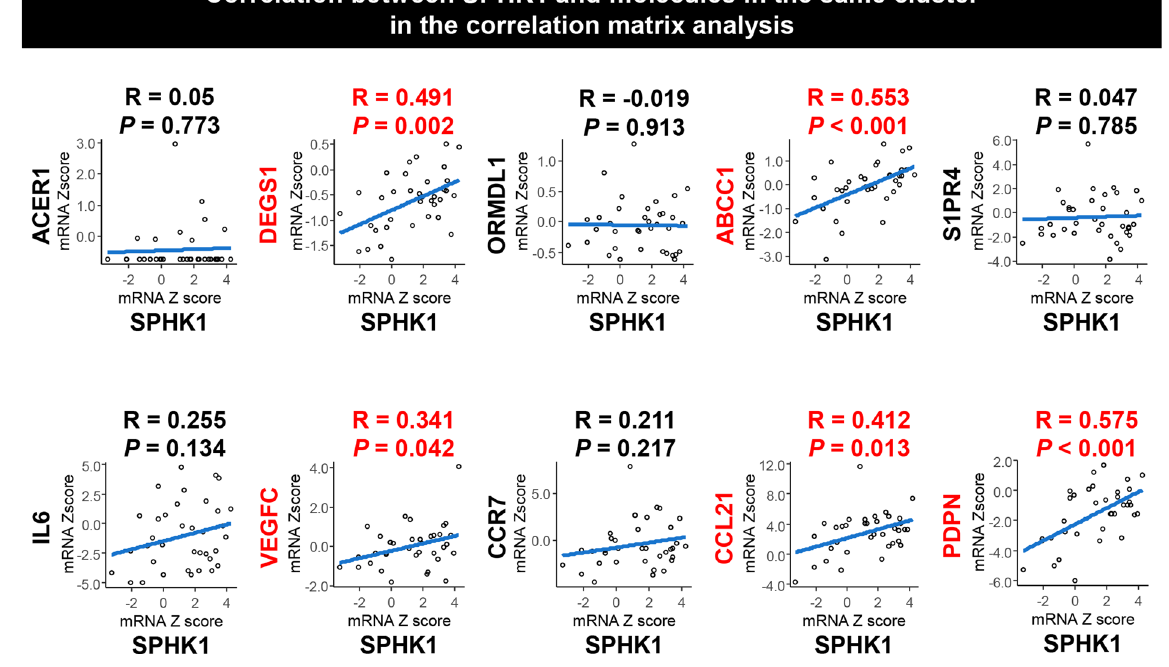
Figure 5. The gene expression level of SPHK1 positively correlated with those of lymphangiogenesis-related or lymphatic metastasis-related substrates in biliary tract cancer. Pearson correlations were calculated between gene expression level of SPHK1 and those of ACER1, DEGS1, ORMDL1, ABCC1, S1PR4, IL6, VEGFC, CCR7, CCL21 and PDPN in biliary tract cancer in TCGA cohort (36 samples of cancer tissue in cholangiocarcinoma cohort). All tests were two-sided, and P values < 0.05 were considered statistically significant.